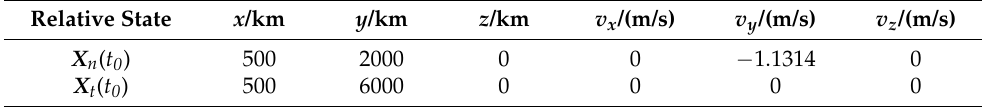
Table 3. The initial state of the nano-satellite and the